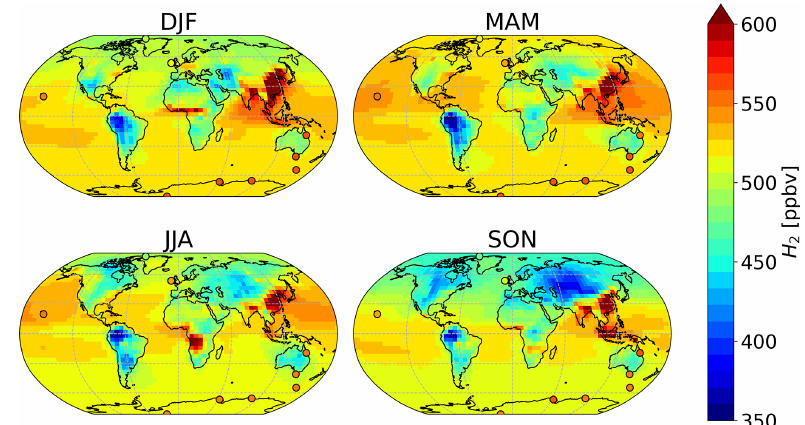
Figure 4. Average surface air H 2 mixing rations in each season as estimated by the GEOS-Chem baseline simulation (background), compared against average measured values from CSIRO (circles). Both modeled and observed values have been averaged over